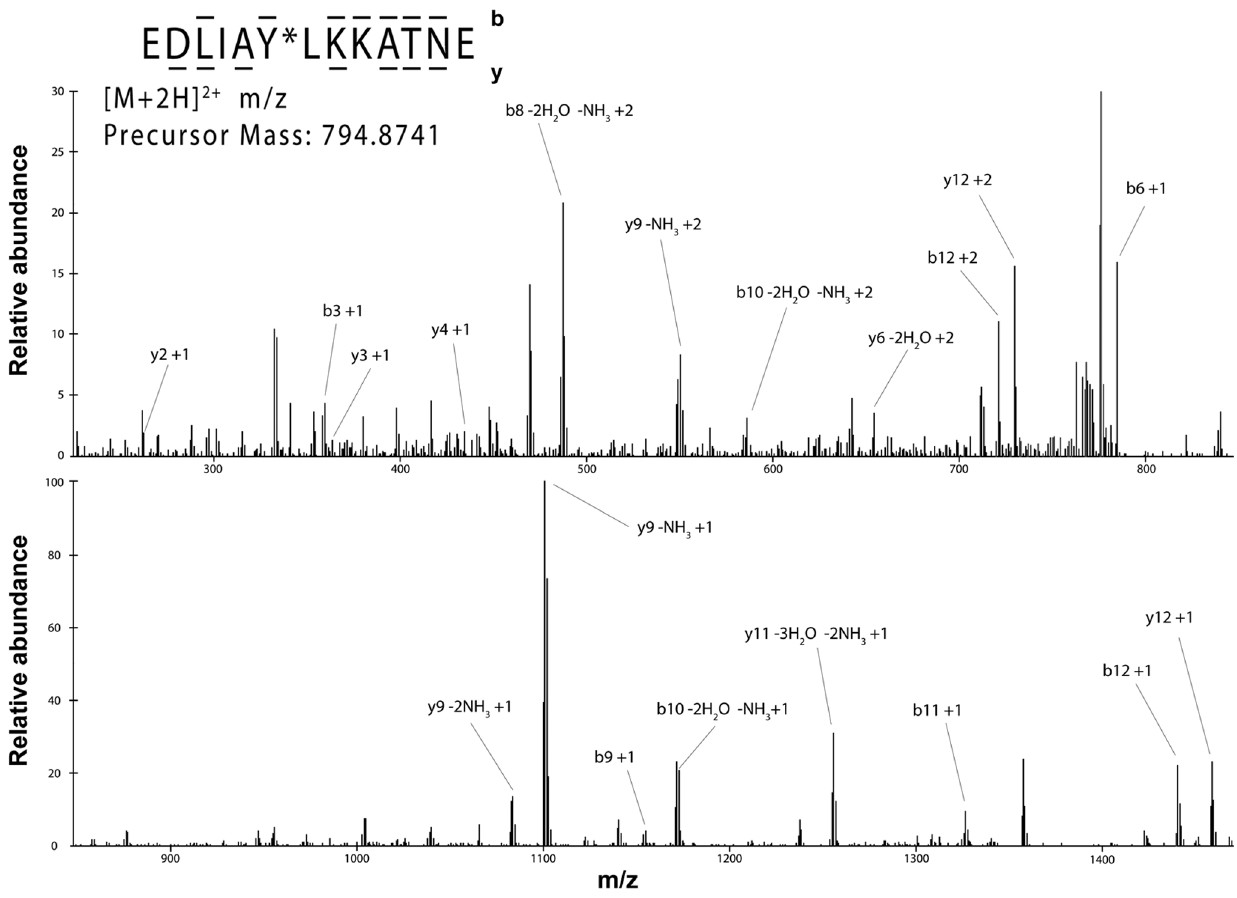
Figure 4. Nano-LC/ESI-MS/MS spectrum of EDLIApYLKKATNE. Peptides were eluted into the mass spectrometer by applying a HPLC gradient of 0–70% 0.1 M acetic acid/acetonitrile in 30 minutes. The mass spectrometer acquired top 9 data dependent ESI MS/MS spectra. The phosphorylation site was unequivocally assigned by fragment ions b6, b8, b9, b10, and y3, y4, y6. The sequence of the peptide was definitively assigned by b3, b6, b8, b9, b10, b11, b12, and y2, y3, y4, y6, y9, y10, y11.